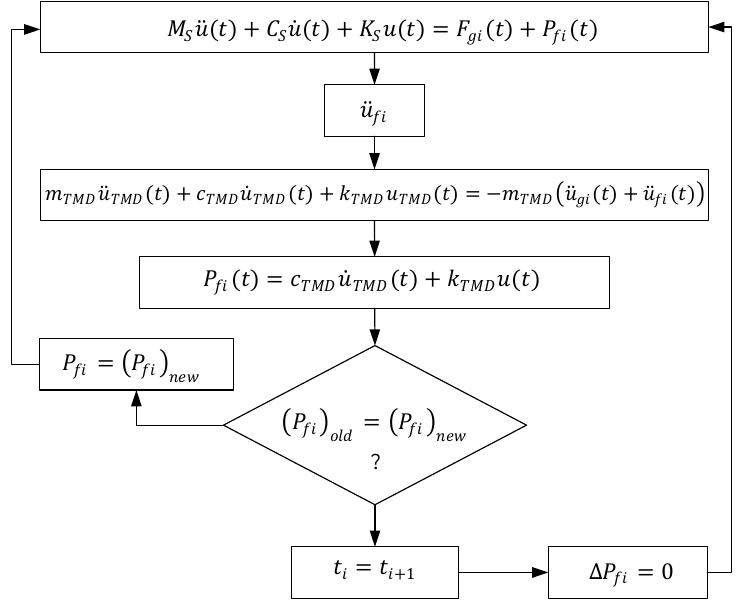
Figure 6. Mathematical technique for the effectiveness of TMD.